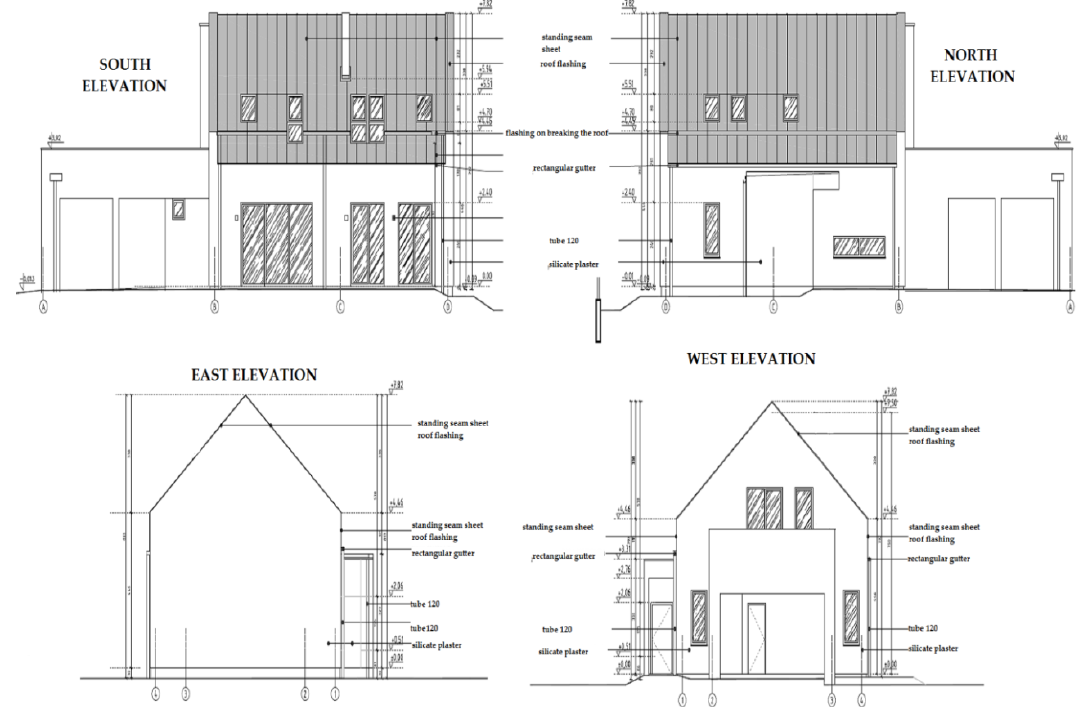
Figure 3. Views of the facade of the building by orientation. Table 2. Heat transfer coe ffi cient U c of the main building